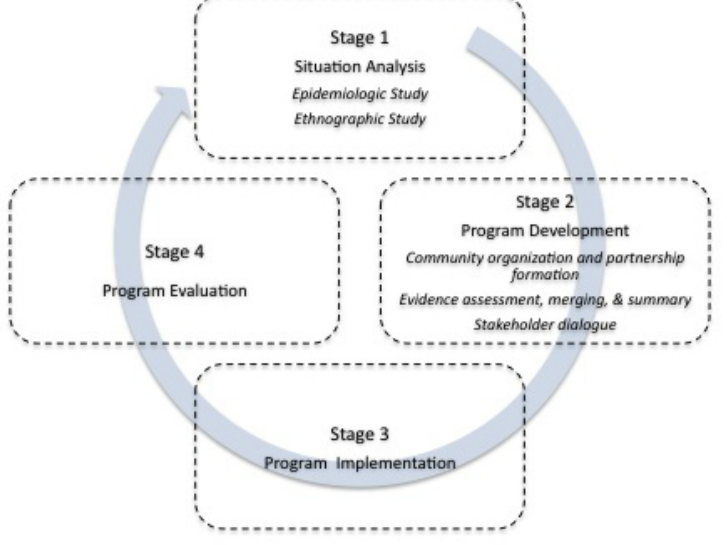
Figure 1. The “Community-Based Rehabilitation for Low Income Communities Living With Rheumatic Diseases (CONCORD)”